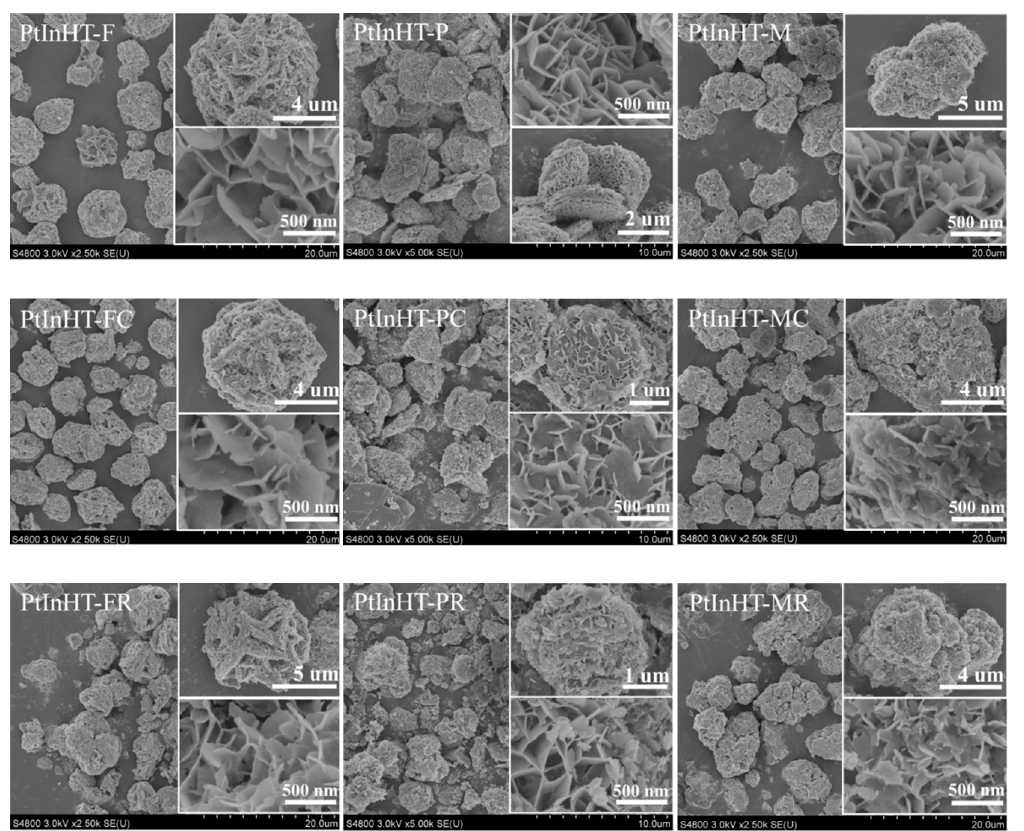
Figure 3. SEM images of HT precursor, calcined, reconstructed and reduced samples with di ff erent morphologies.